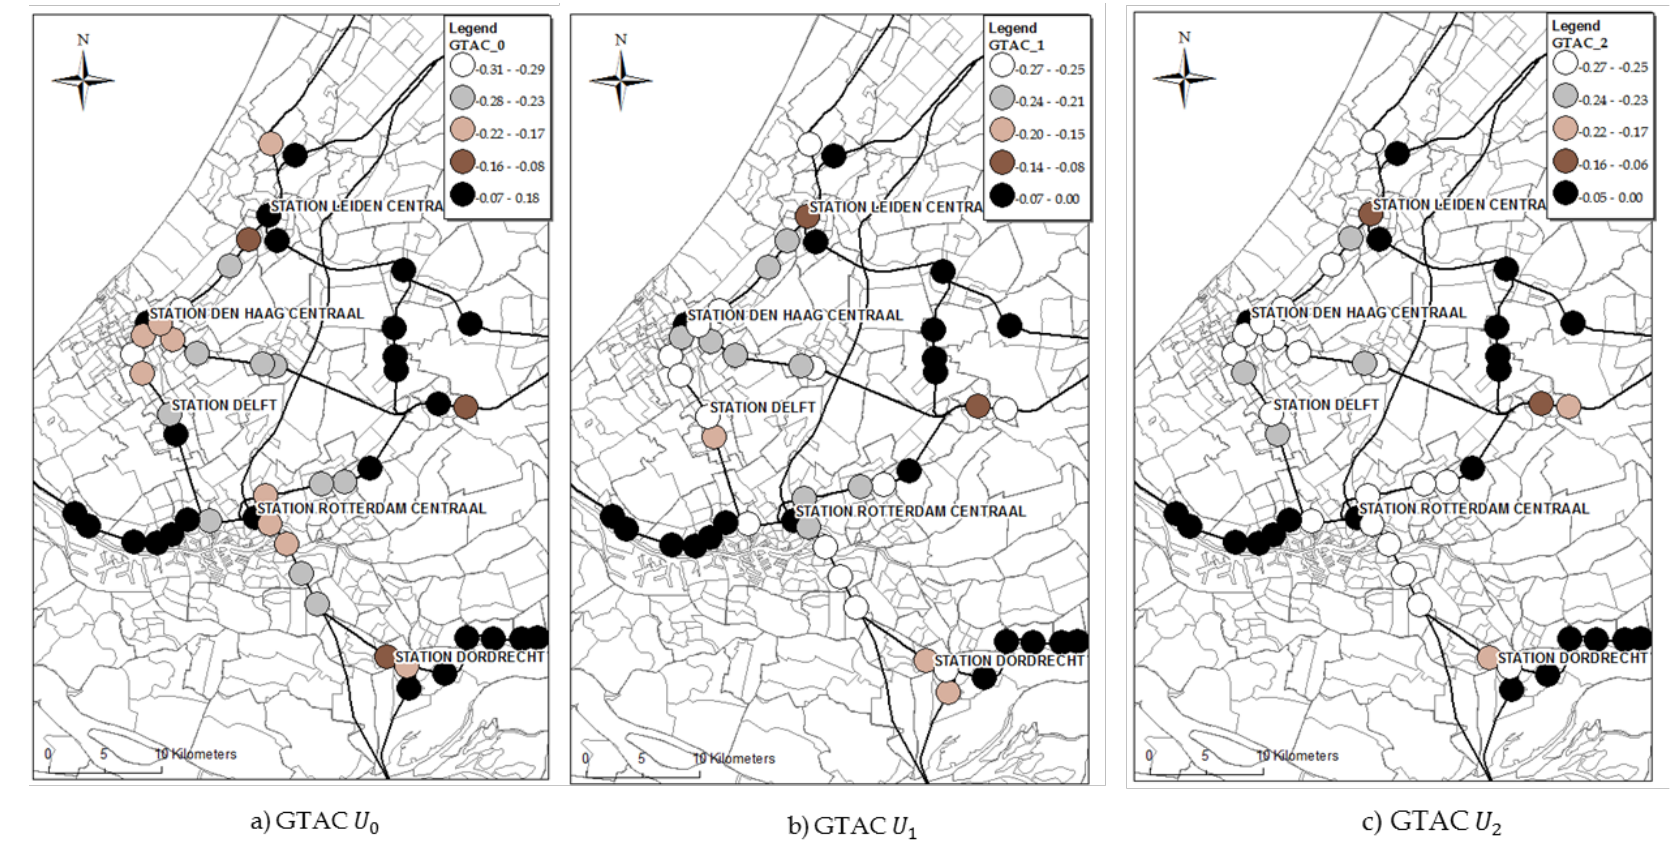
Figure 4. Comparison of average GTAC from U 0 (logit), U 1 (station) and U 2